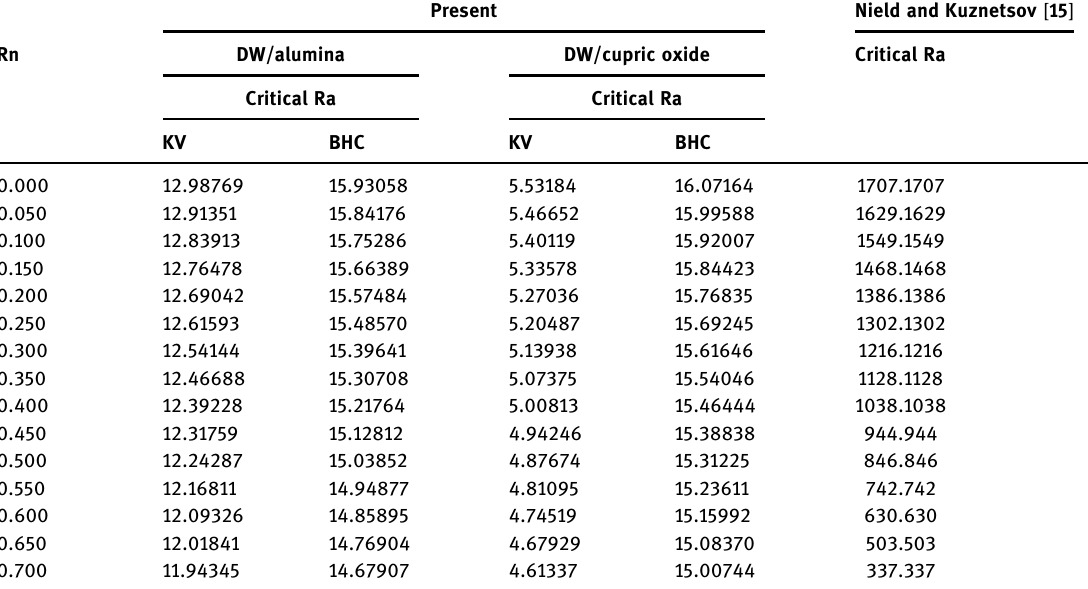
Table 1: Numerical results of the e ff ect of the concentration Rayleigh number, Rn , on the critical thermal Rayleigh number, Ra